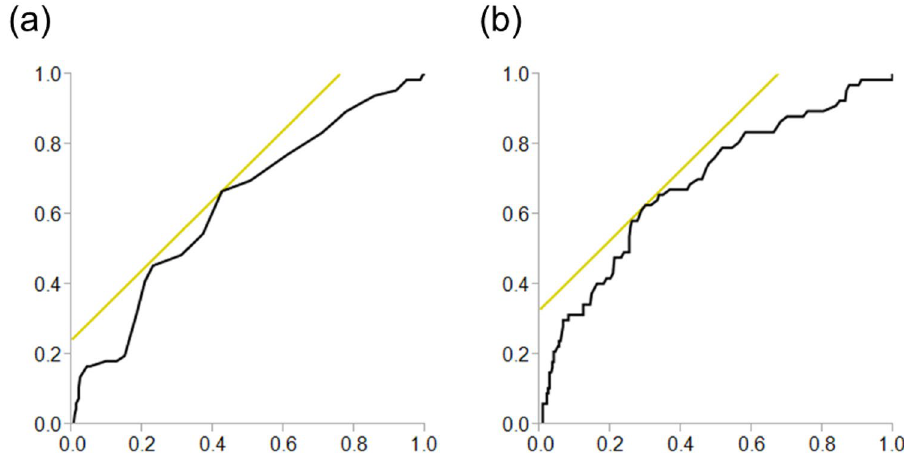
Figure 1. Receiver operating characteristic curves for albumin and the neutrophil to lymphocyte ratio for predicting acute kidney injury. ( a ) albumin, ( b ) neutrophil to lymphocyte ratio.